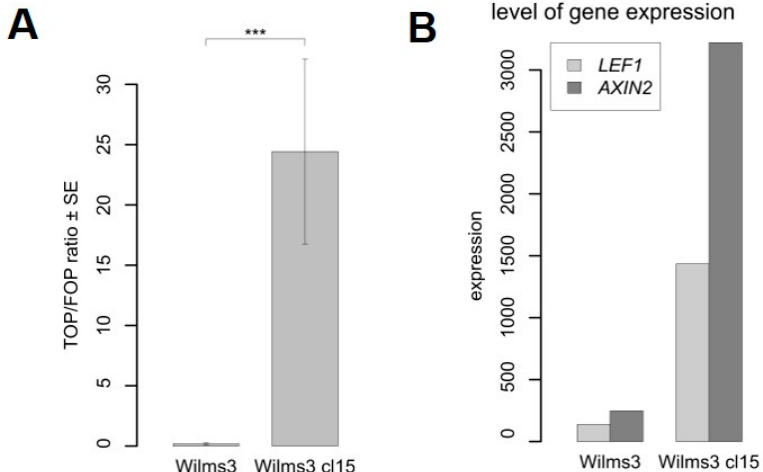
Figure 3. Analysis of the Wnt signaling pathway in Wilms3 cells with or without mutant CTNNB1 . ( A ) Transient transfection assay of Wilms3cl15, with CTNNB1 mutation and Wilms3 cells with wild type CTNNB1 , with TOP- and FOP-flash reporter plasmids and analysis of the luciferase activity. The TOP to FOP ratio is displayed relative to the internal Renilla control plasmid. The standard error was derived from three independent experiments. *** = p -Value < 0.001. ( B ) Level of Wnt target gene expression in Wilms3cl15 and Wilms3 cells determined by Agilent whole genome expression arrays.